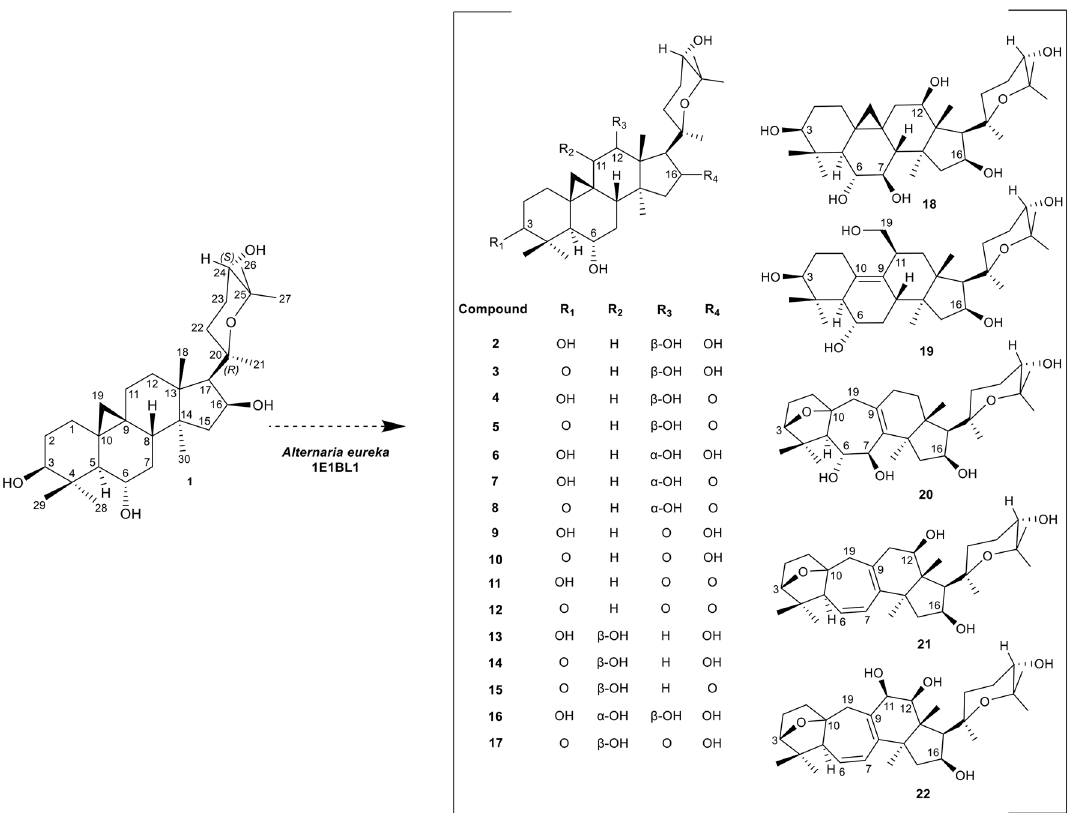
Figure 2. Biotransformation products of cyclocephagenol ( 1 ) by Alternaria eureka